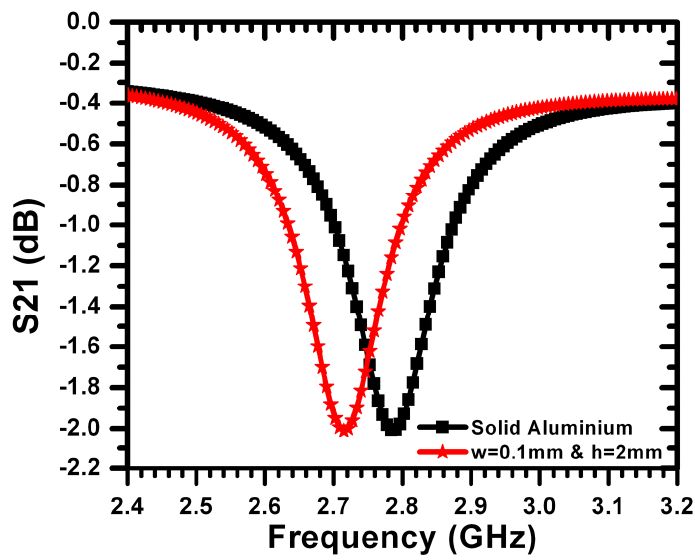
Figure 17. Minimum transmission of the new CSRR sensor for a crack width (w) of 100 µ m, and the crack depth (h) is 2 mm compared with solid